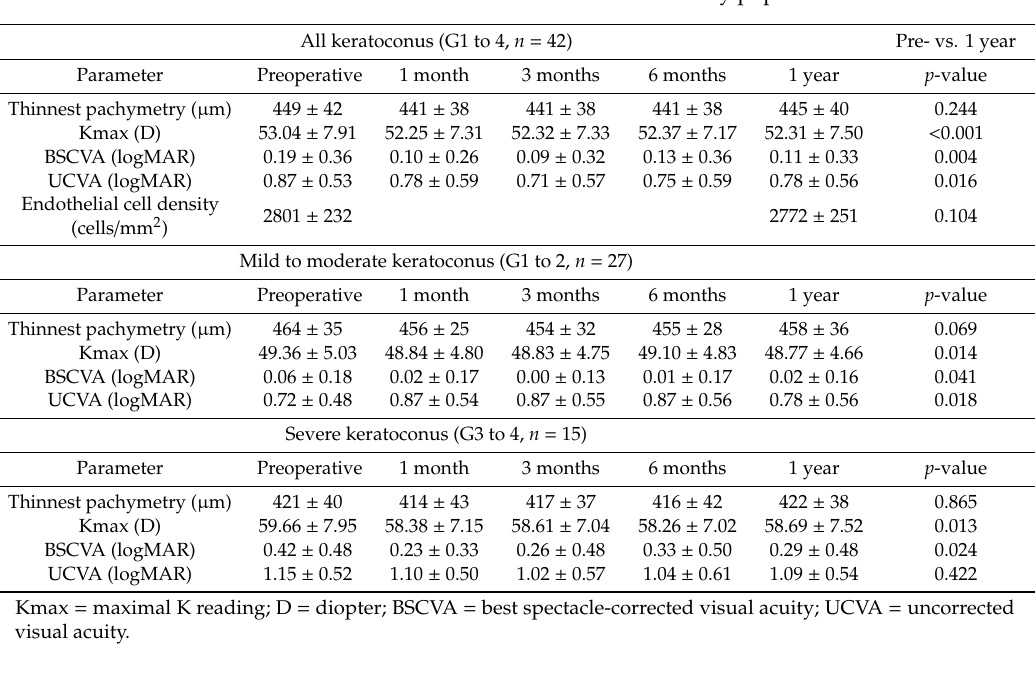
Table 2. Time courses of outcome measures in the study population.